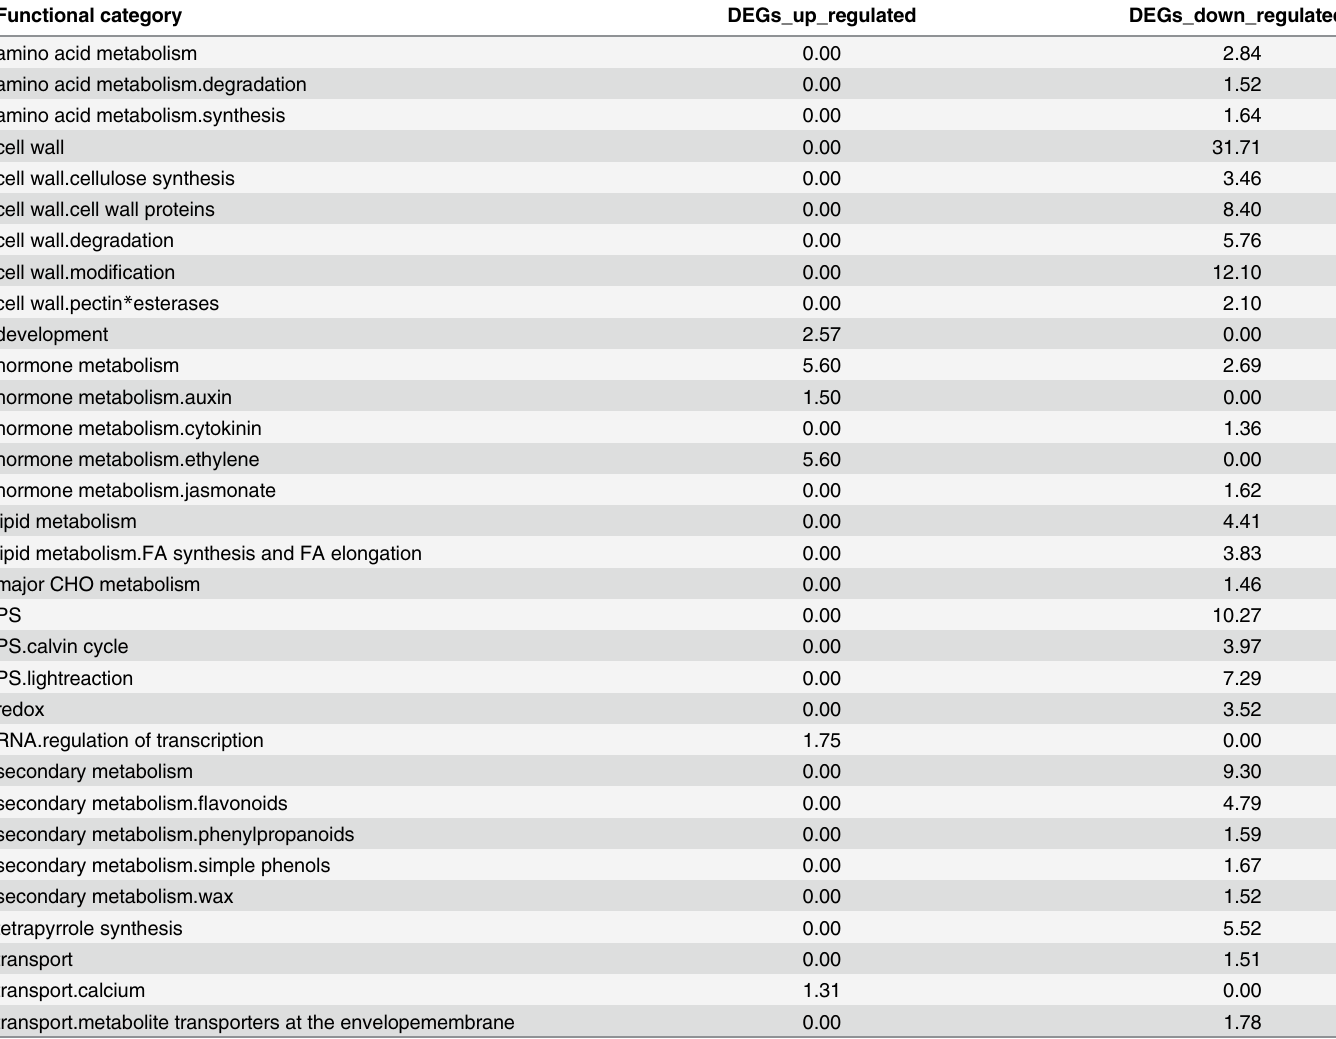
Table 1. Summary of functional categories of 507 up-regulated and 611 down-regulated DEGs in VFP3 RNAi plants. Numbers represent -log10(q- value). Functional